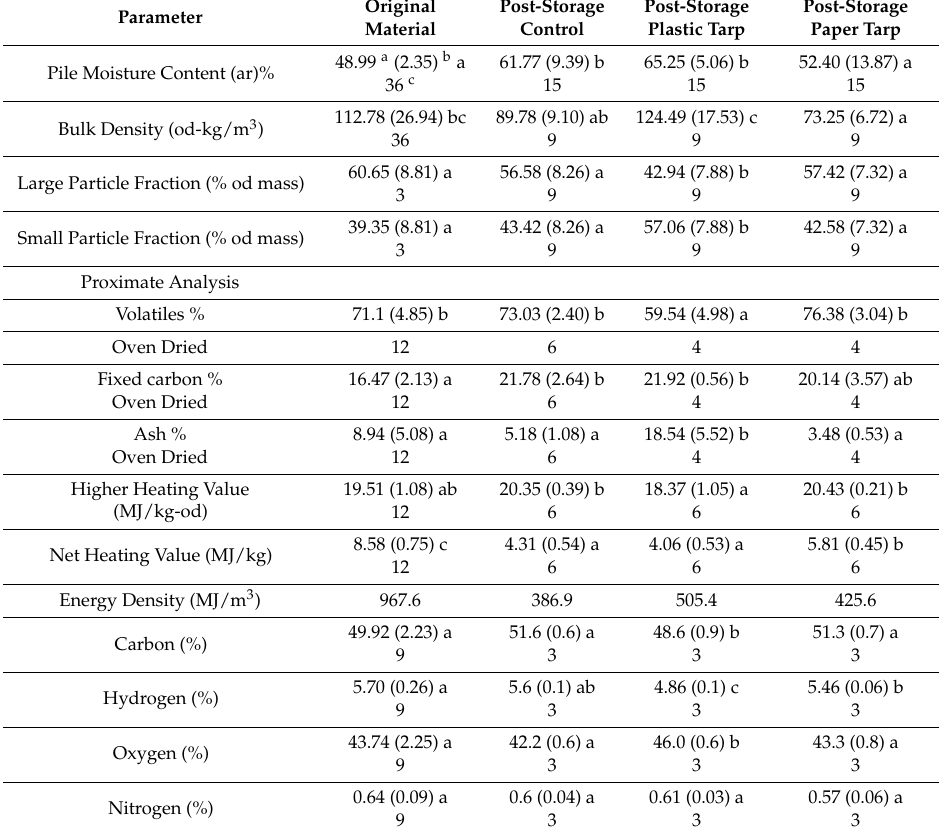
a Numbers in table are mean values; b Values in parentheses are the standard deviations; c Values below means and standard deviations denote sample size; Different letters across rows denote a significant difference according to Tukey’s HSD at the 95% confidence